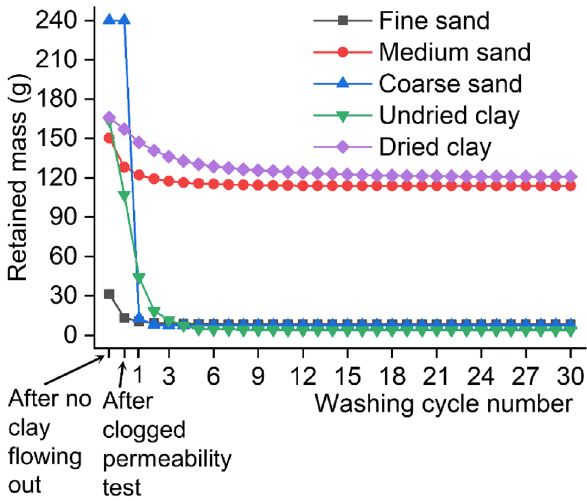
Figure 6. The mass of retained particles after completing different experimental